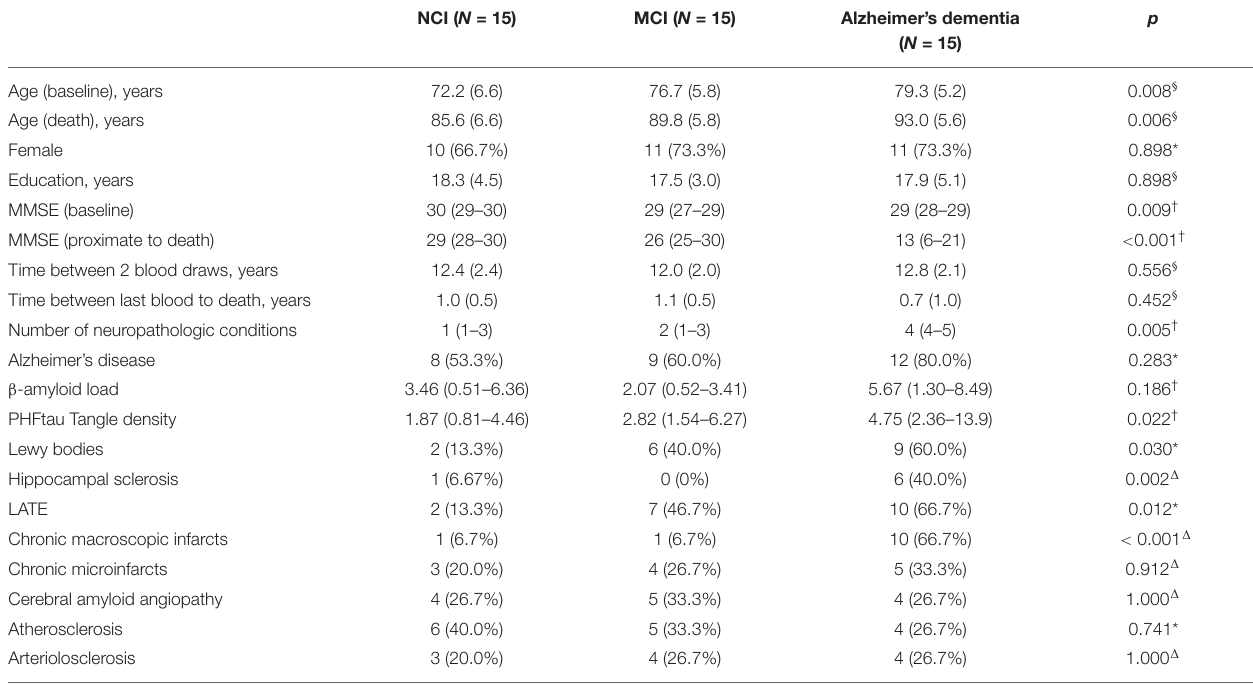
TABLE 1 | Demographic, clinical and neuropathologic